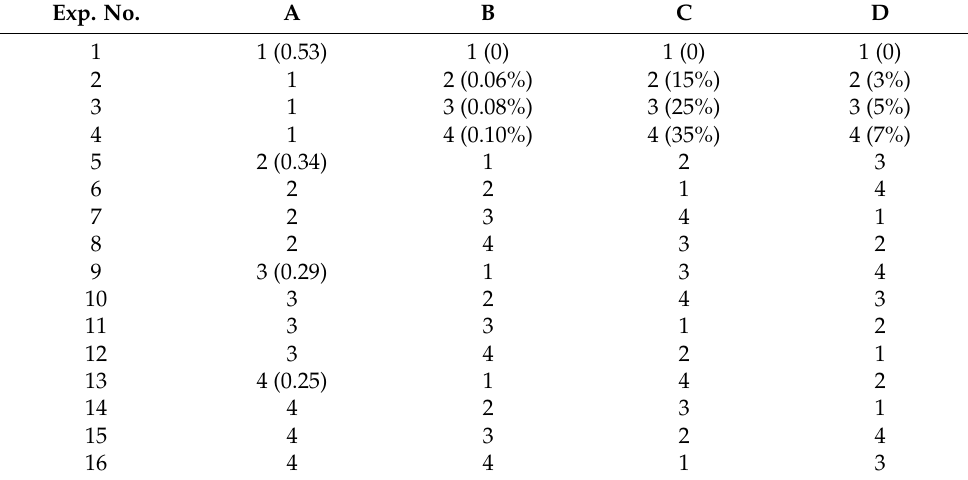
Table 5. Orthogonal layout of four factors with four